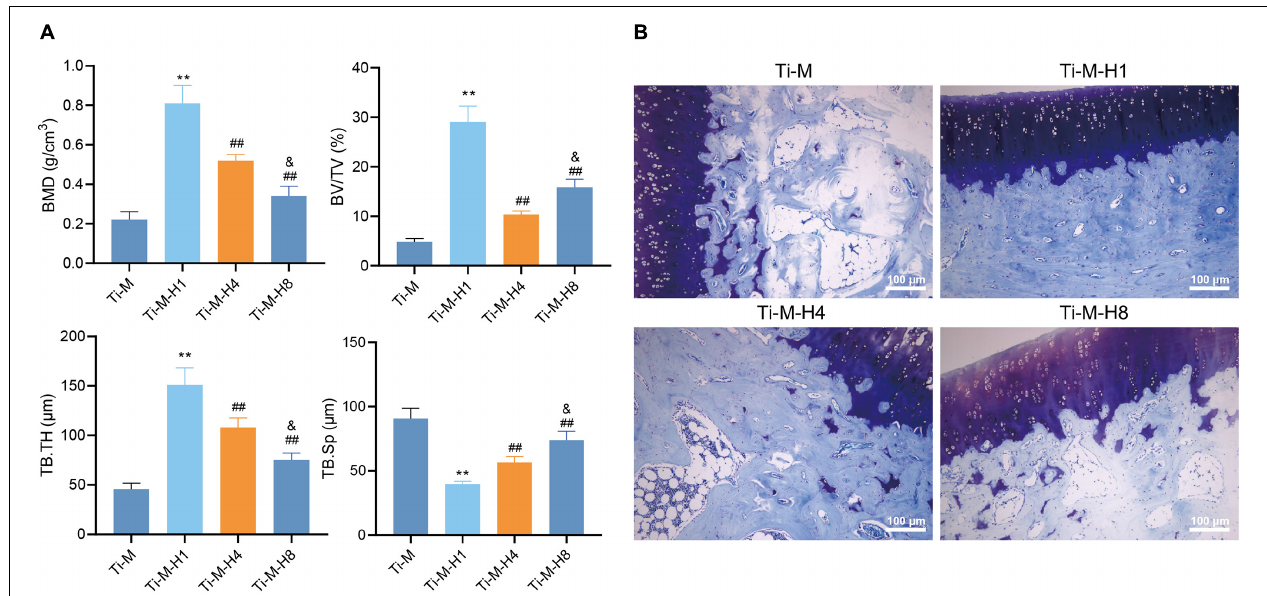
FIGURE 5 | Osteogenesis of in vivo implants. (A) The micro-architectural parameters displayed by the three-dimensional reconstructed µ CT image, including bone mineral density, bone volume fraction, and trabecular thickness, and trabecular separation. (B) Images of toluidine blue staining. * P < 0.05 compared with Ti–M. # P < 0.05 compared with Ti–M–H1. & P < 0.05 compared with Ti–M–H4. ** P < 0.01 compared with Ti–M. ## P < 0.01 compared with Ti–M–H1. && P < 0.01 compared with Ti–M–H4. The experiments were repeated three